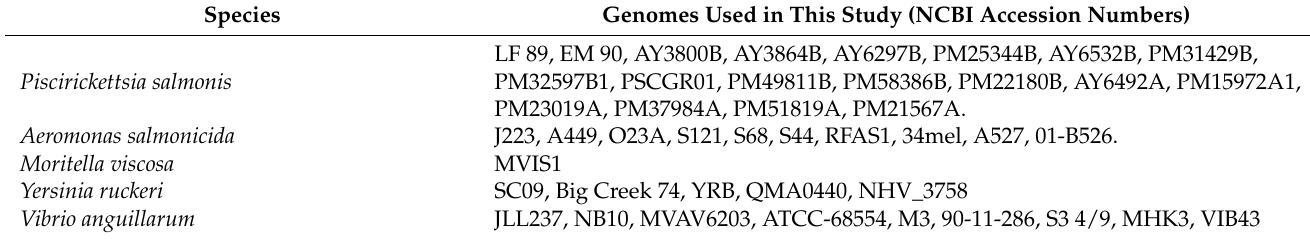
Table 1. Bacterial strains used for this study. Genomes Used in This Study (NCBI Accession